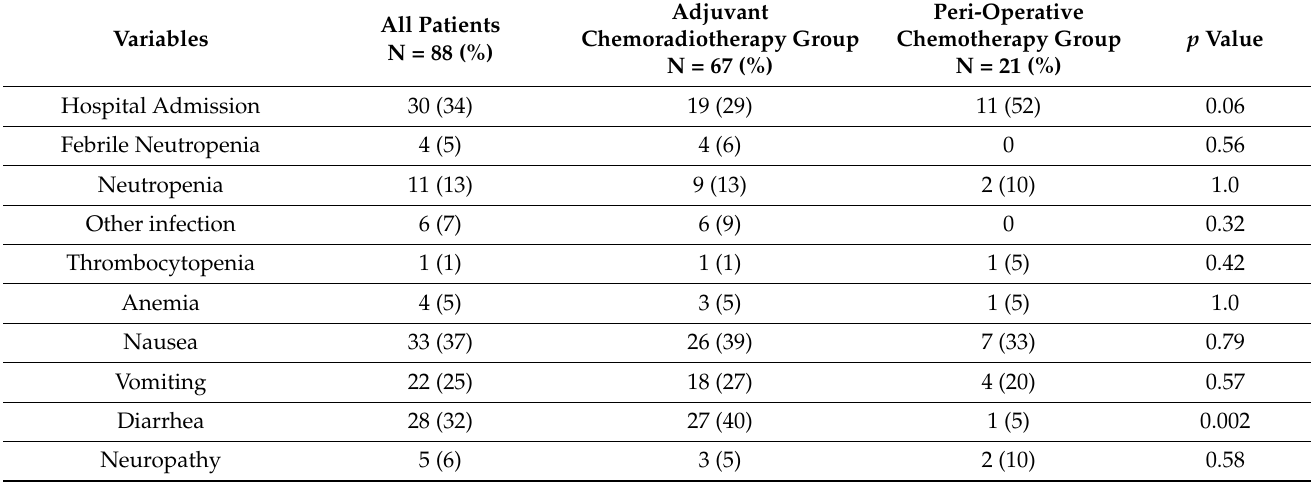
Table 4. Treatment toxicities ( ≥ grade 2) in patients with early stage stomach and GE junction cancers who received adjuvant chemoradiotherapy versus perioperative